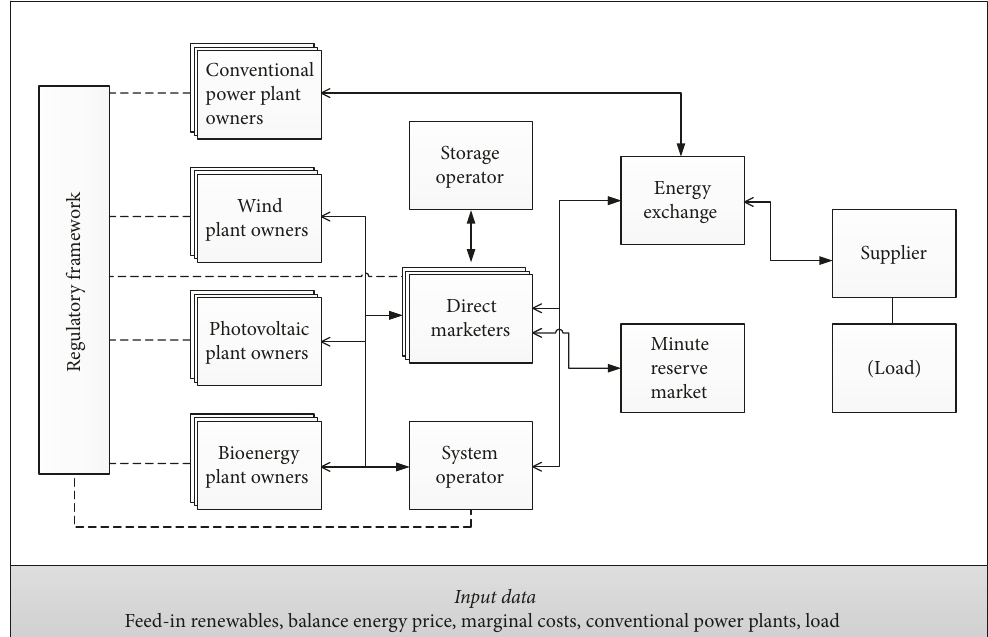
Figure 2: The AMIRIS